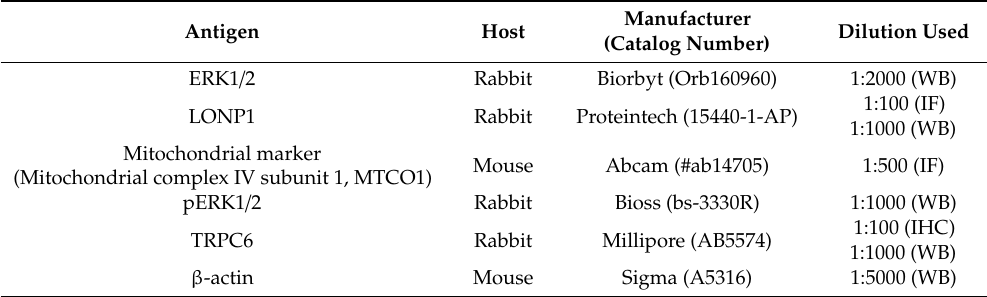
Table 1. Primary antibodies used in the present